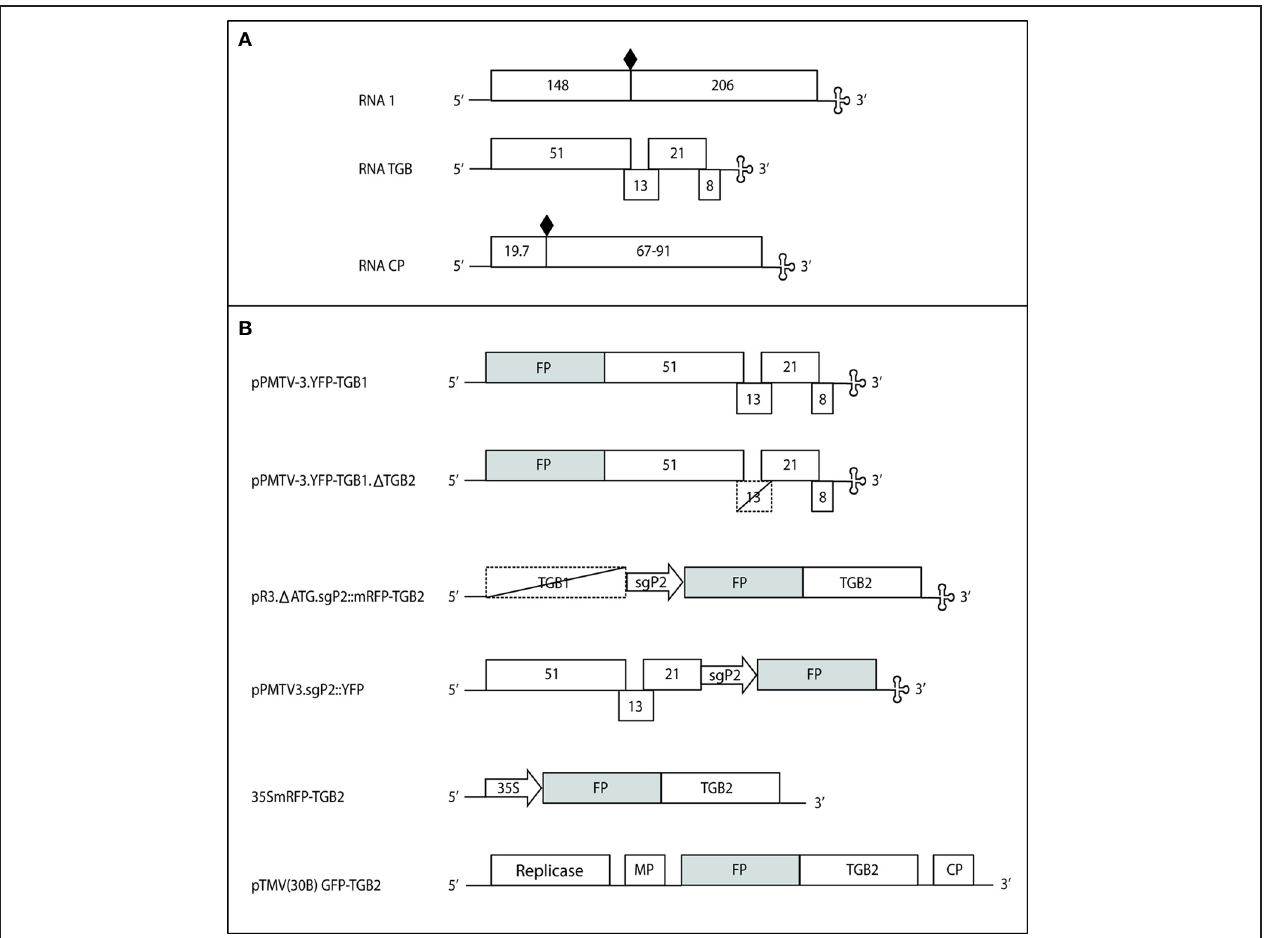
FIGURE 1 | PMTV genome (A) and constructs derived from RNA TGB (B). The viral RNA1 encodes the 148K replication protein and the 206K read-through (RT) product. RNA TGB encodes the three overlapping TGB proteins (51K, 13K, and 21K) and an 8K cysteine-rich protein. RNA CP encodes the 19.7K coat protein and itsRTdomain. Diamonds, leaky termination codons;